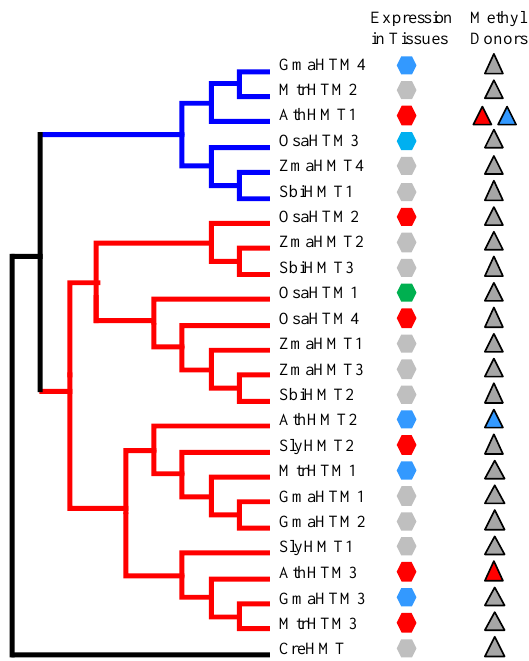
Figure 4. The expression patterns of HMT genes in represented plants. The maximum likelihood (ML) tree of HMT s in Arabidopsis , soybean, Medicago , tomato, rice, maize and sorghum was reconstructed with the outgroup of CreHMT . Class 1 and Class 2 are marked by red and blue lines, respectively. The expression patterns of tissues and methyl donors are matched to the tree. The red, green, and blue hexagons indicate that their expression were high in reproductive tissues, vegetative tissues, and fluctuant in various tissues, respectively. The gray hexagons denote their expression were unknown. The blue and red triangles indicate the methyl donors R , S -SAM and SMM, respectively. The gray triangles indicate that their methyl donors are unknown.